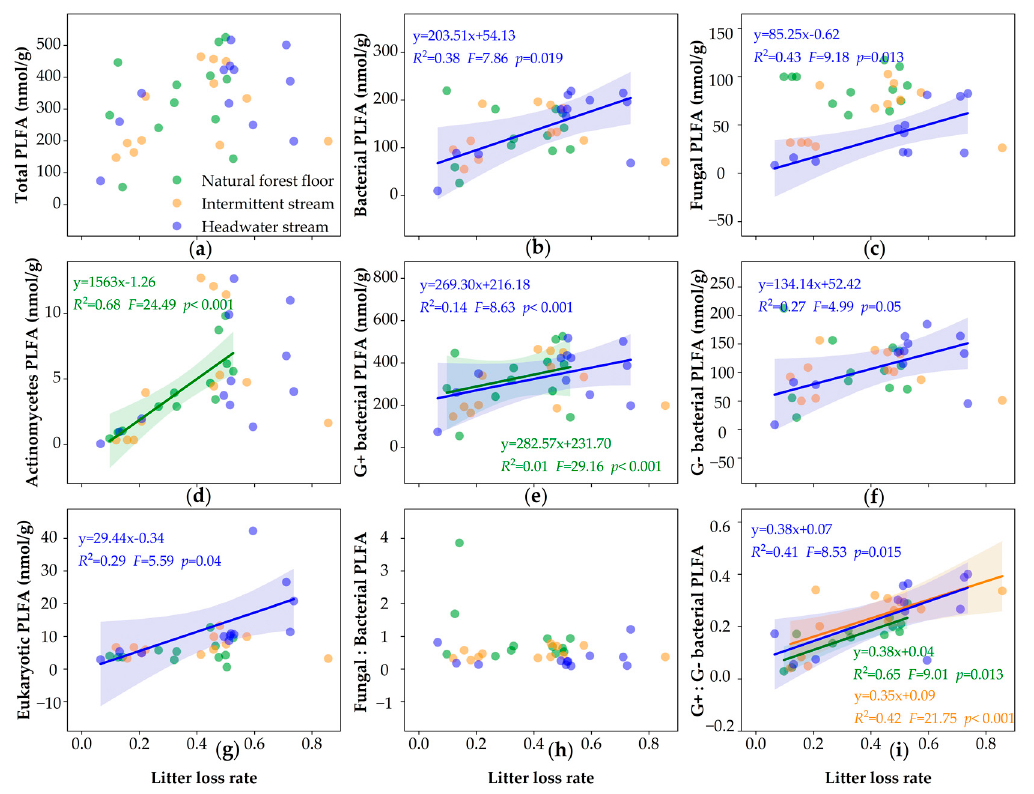
Figure 5. Linear regression for three habitats between litter mass loss and the concentrations of microbial total PLFA ( a ) and PLFA of microbial groups ( b – g ), and the ratios of biomarkers ( h, i ).